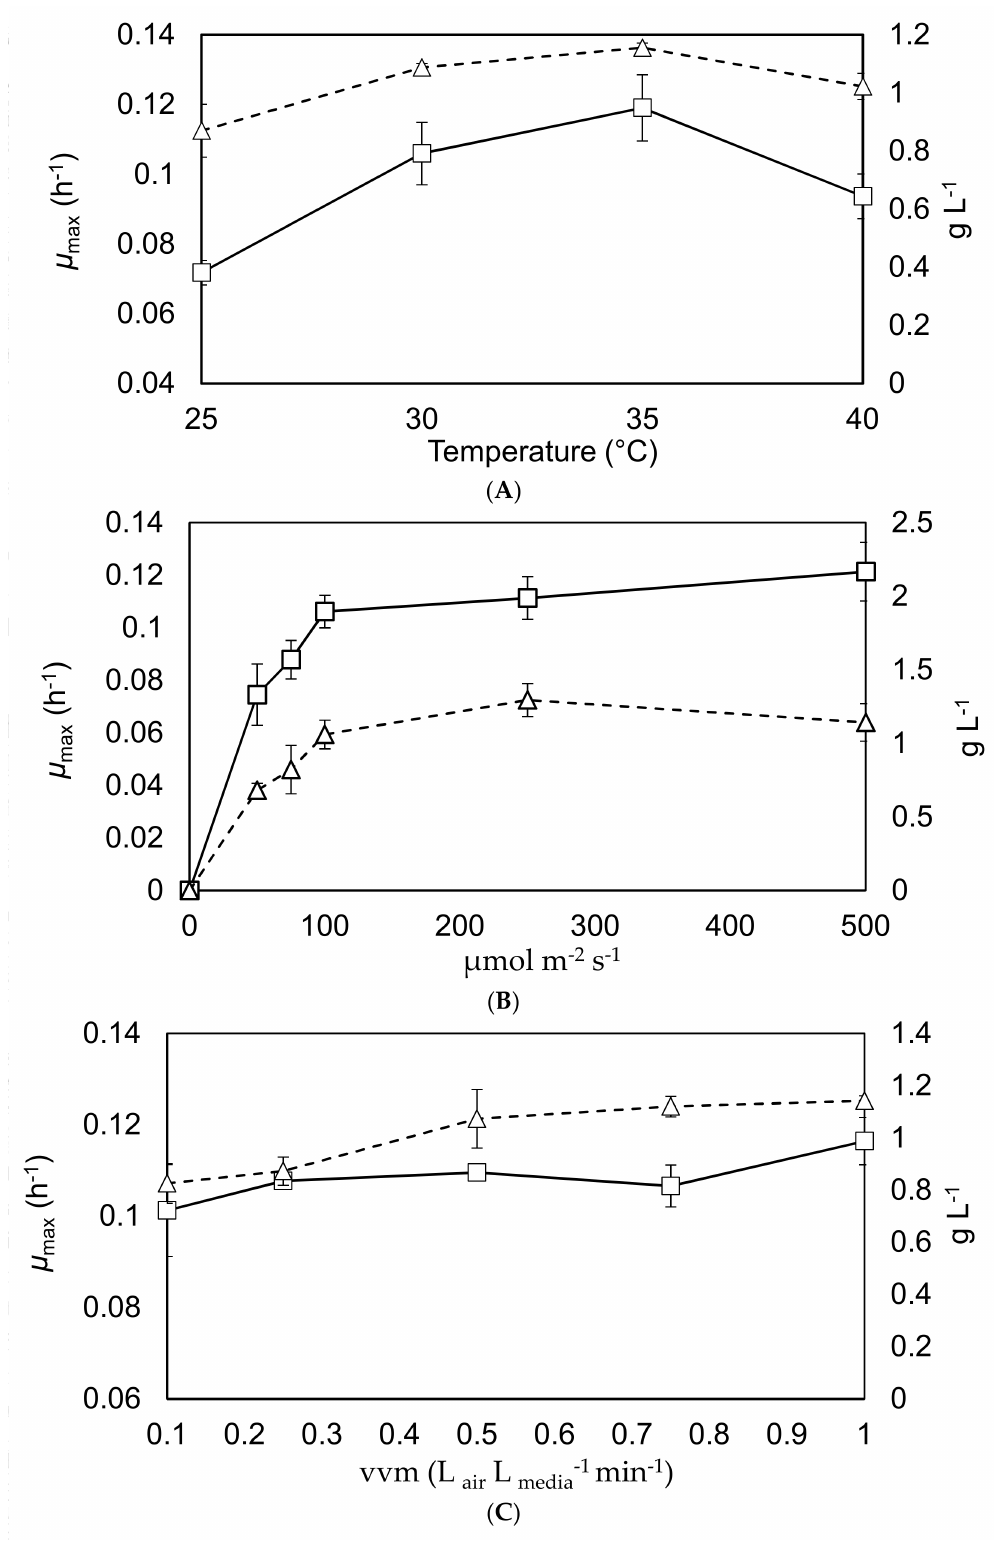
Figure 3. Maximum specific growth rates and final yields in the 1 L Duran bottle reactors. The primary y-axis shows the maximal growth rates (square markers, solid black lines), while the secondary y-axis shows the final yield after a 7-day batch (triangle marker, dashed black lines). Graph ( A ) demonstrates the effect of altering the temperature. Graph ( B ) indicates the response to changing the surface irradiance. Graph ( C ) demonstrates the effect caused by changing the agitation. Triplicate experiments, error bars show 2 standard deviations from the